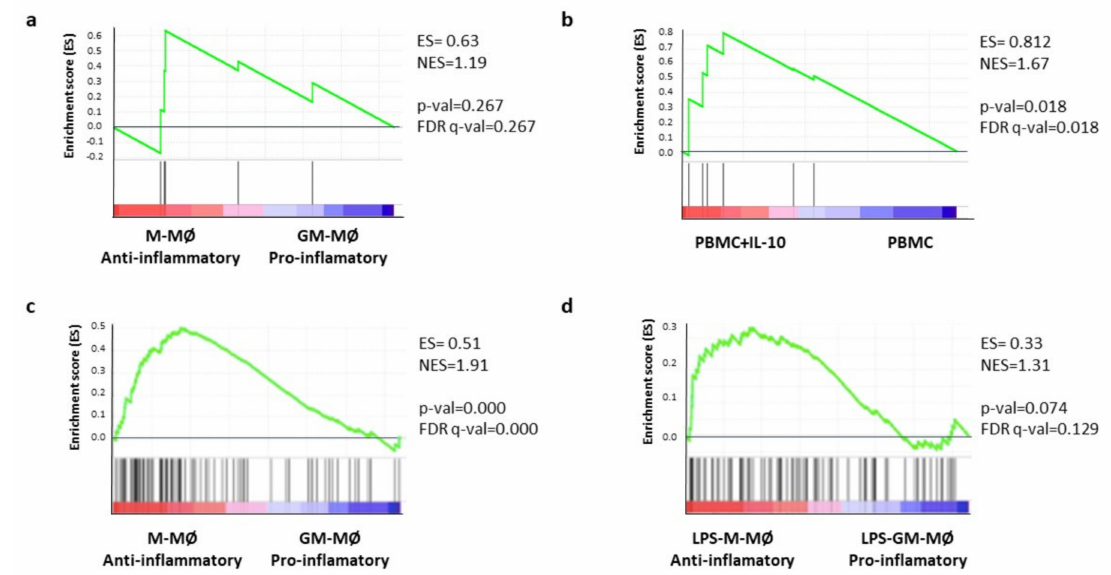
Figure 5. Gene-set enrichment analysis (GSEA) between gene expression and macrophage signatures. Gene-set enrichment analysis (GSEA) of the six-gene CD47-immune signature on ( a ) the ranked comparison of anti-inflammatory macrophages (M-MØ) or M2 and monocyte-derived pro-inflammatory (GM-MØ) or M1 whole transcriptomes, previously described in [20,22] (GSE27792 and GSE68061) or ( b ) the transcriptomes of adherent human peripheral blood mononuclear cells either untreated (PBMC) or treated with 10 ng/mL IL-10 for 24 h (PBMC + IL-10) that have been previously described. GSEA of the genes that positively correlate with CD47 and are associated with good prognosis (Figure S1) on ( c ) the ranked comparison of M-MØ or M2 and GM-MØ or M1 whole transcriptomes, previously described in [21,23] (GSE27792 and GSE68061) or ( d ) the ranked comparison of the transcriptome of lipopolysaccharide (LPS)-treated M-MØ or M2 and LPS-treated GM-MØ or M1 transcriptomes, previously described in [24]